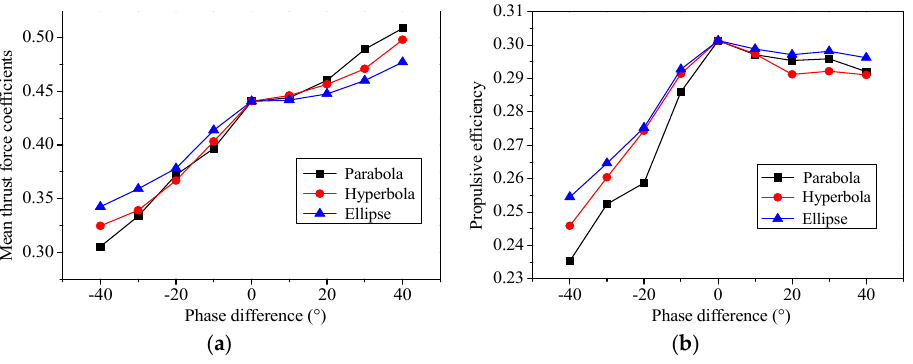
Figure 14. Performance curves versus phase difference of the crescent-shaped foil: ( a ) mean thrust force coefficients; ( b ) propulsive efficiency.